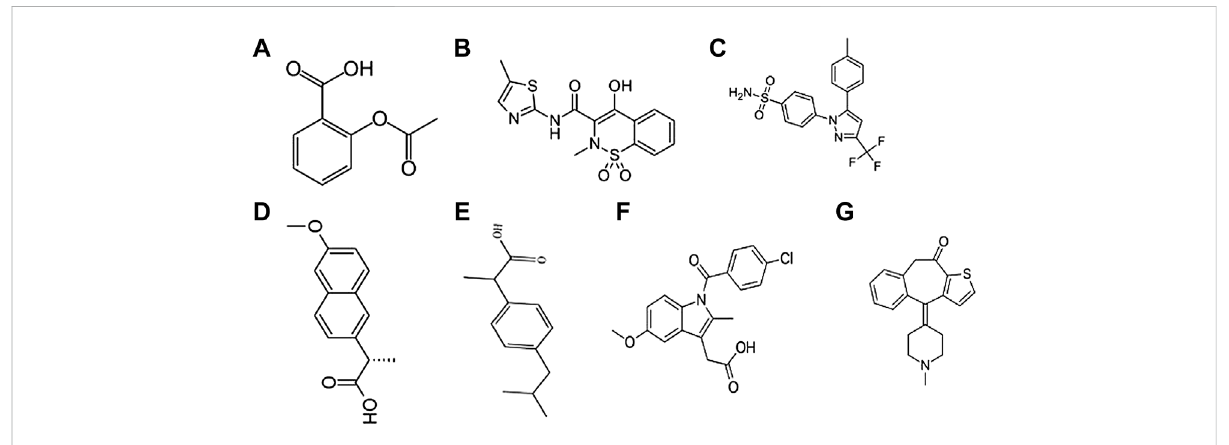
FIGURE 5 Structure of NSAIDS used in the management of COVID-19. (A) Aspirin, (B) Meloxicam, (C) Celecoxib, (D) Naproxen, (E) Ibuprofen, (F) Indomethacin (G)